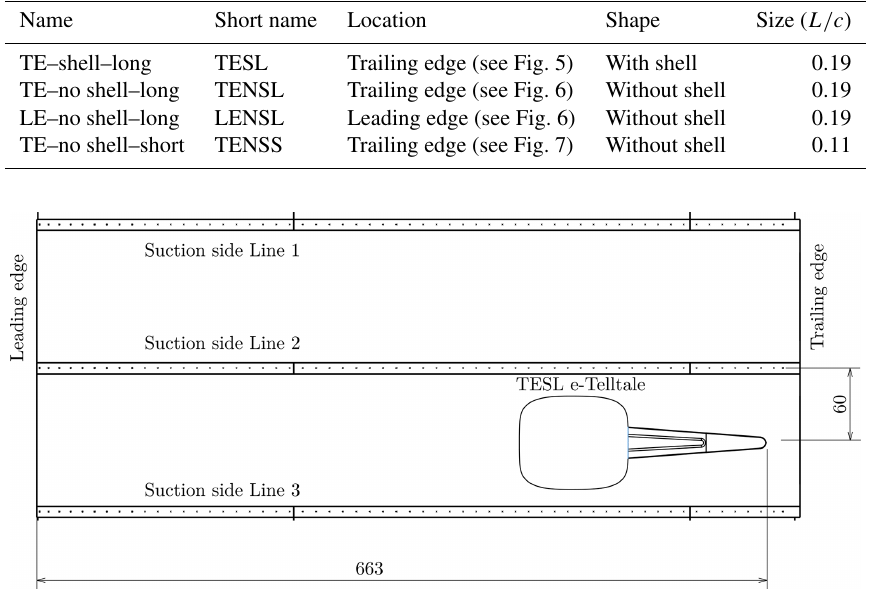
Figure 5. Position of the TESL